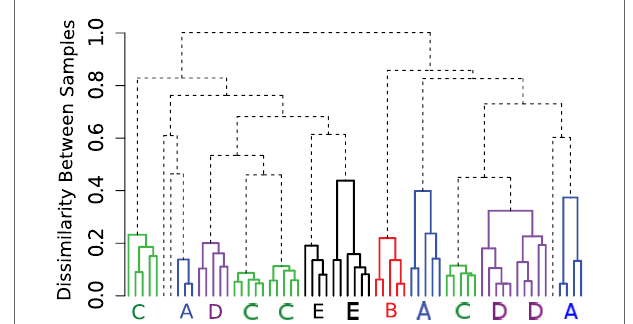
FigUre 9 | hierarchical organization of hD samples using the hM&M algorithm . The Euclidean distance between cluster/meta-cluster centers is used when computing the mixed edge cover.